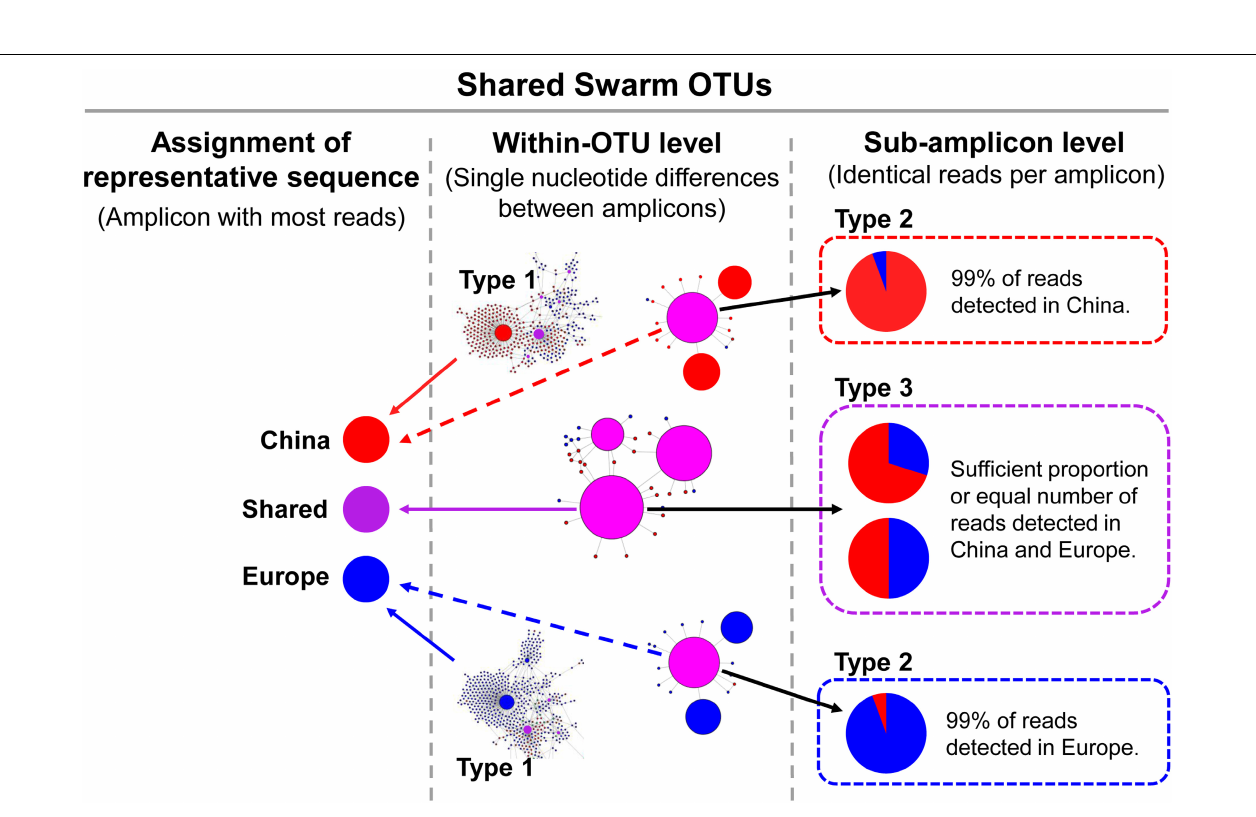
Frontiers in Marine Science |